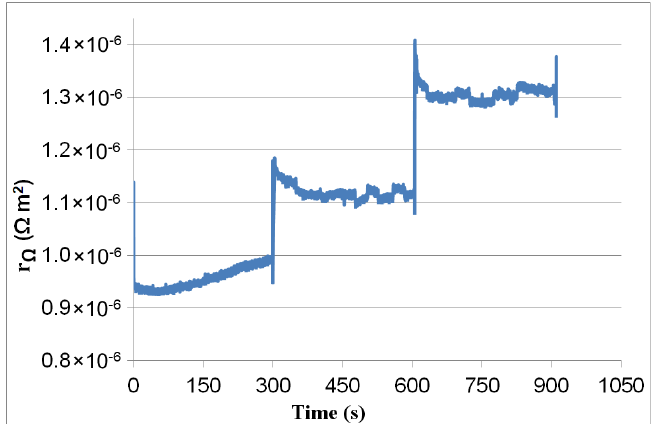
Figure 11. Estimated resistance r Ω